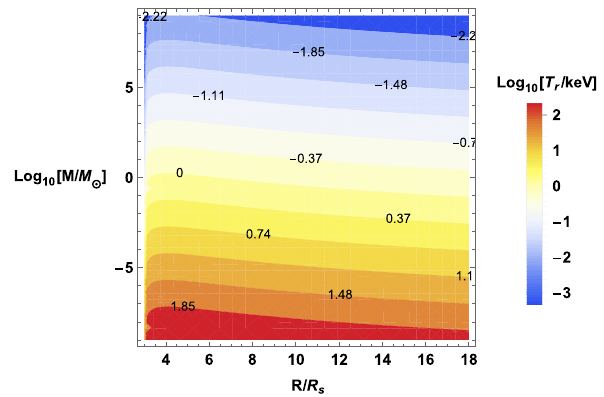
Fig. 2 The contour plot of temperature T r in (3) of thin accretion disk as a function of locations in the disk R / R s and black hole masses M / M (cid:5) , where f e = 1 and f s = 0 . 1 have been taken